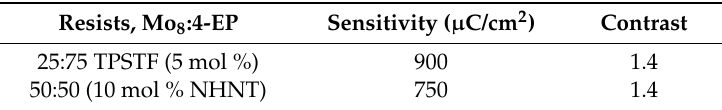
Figure 7. Mo 8 blend contrast curves using EBL. Table 2. Contrast and sensitivity data for EBL exposures.